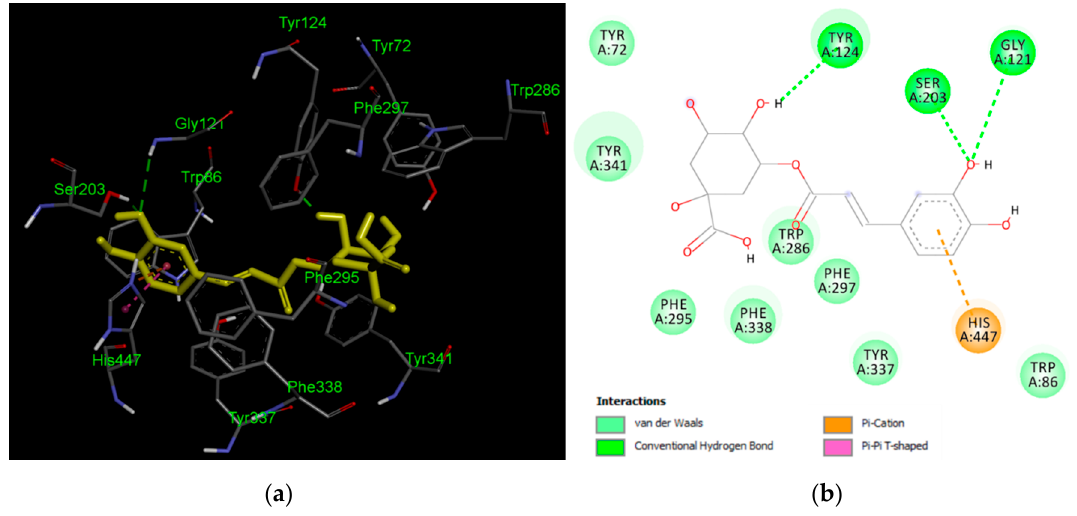
Figure 6. Active site of the AChE enzyme with chlorogenic acid: ( a ) 3D view; ( b ) 2D view.